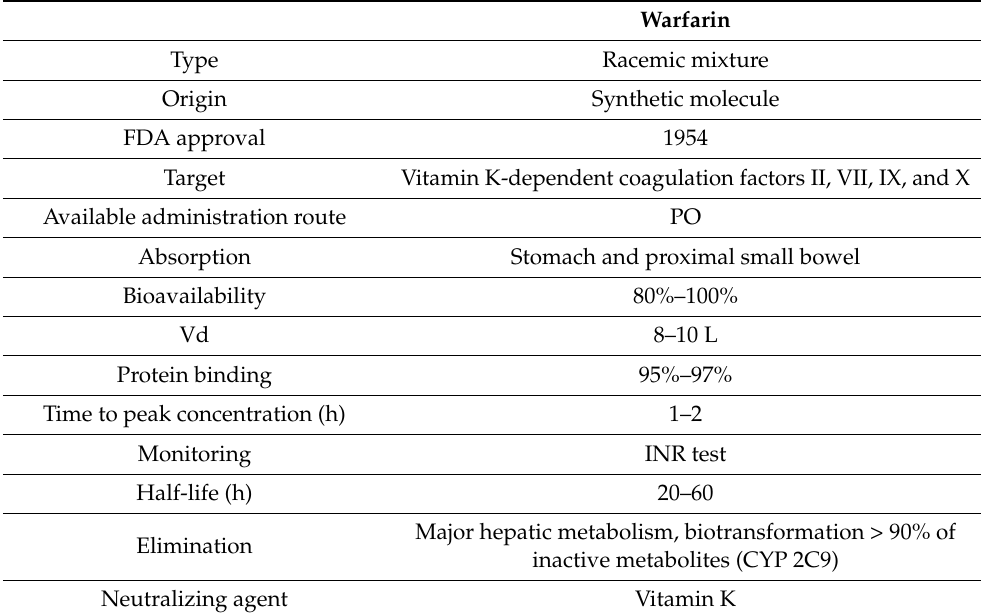
Table 2. Pharmacokinetics of warfarin. Vd: volume of distribution, PO: per os (orally), INR: interna- tional normalized